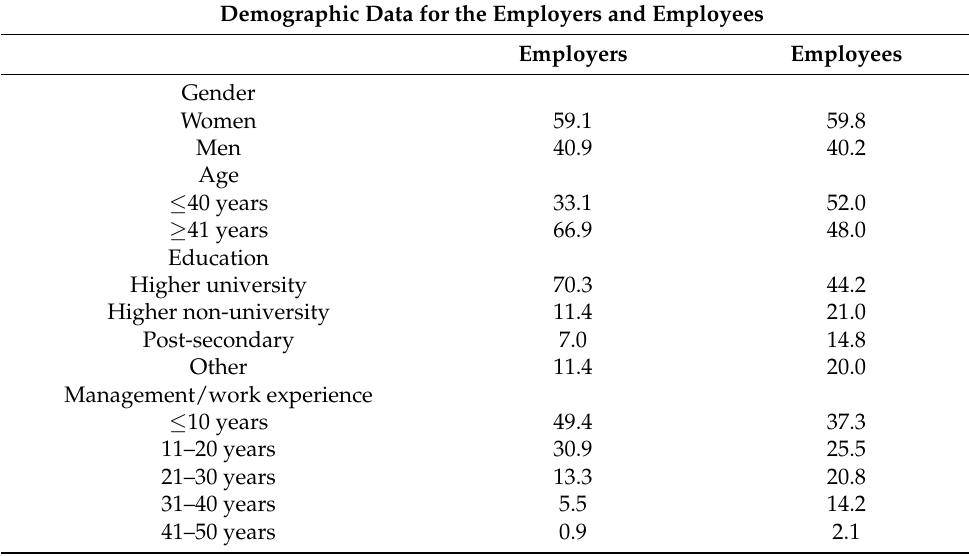
Table 1. Sociodemographic data for the employer and employee groups (%). Demographic Data for the Employers and